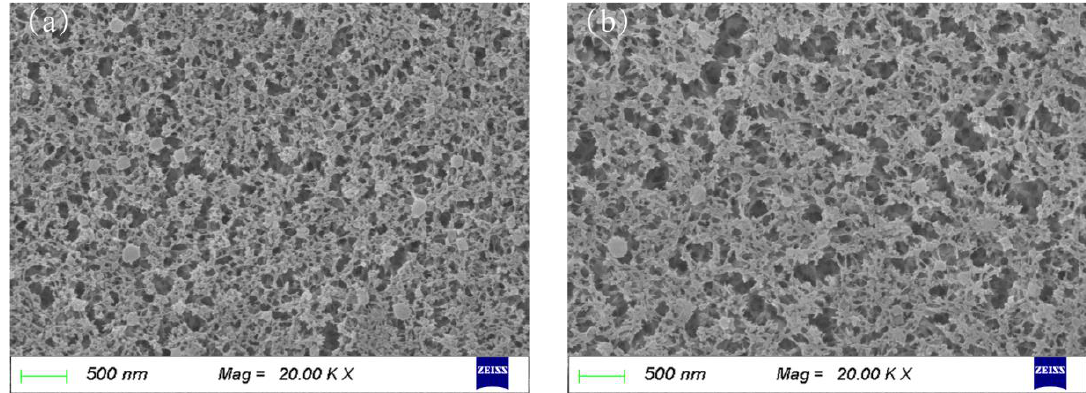
Figure A3. Possible interaction between CMC, DMF, and MC.